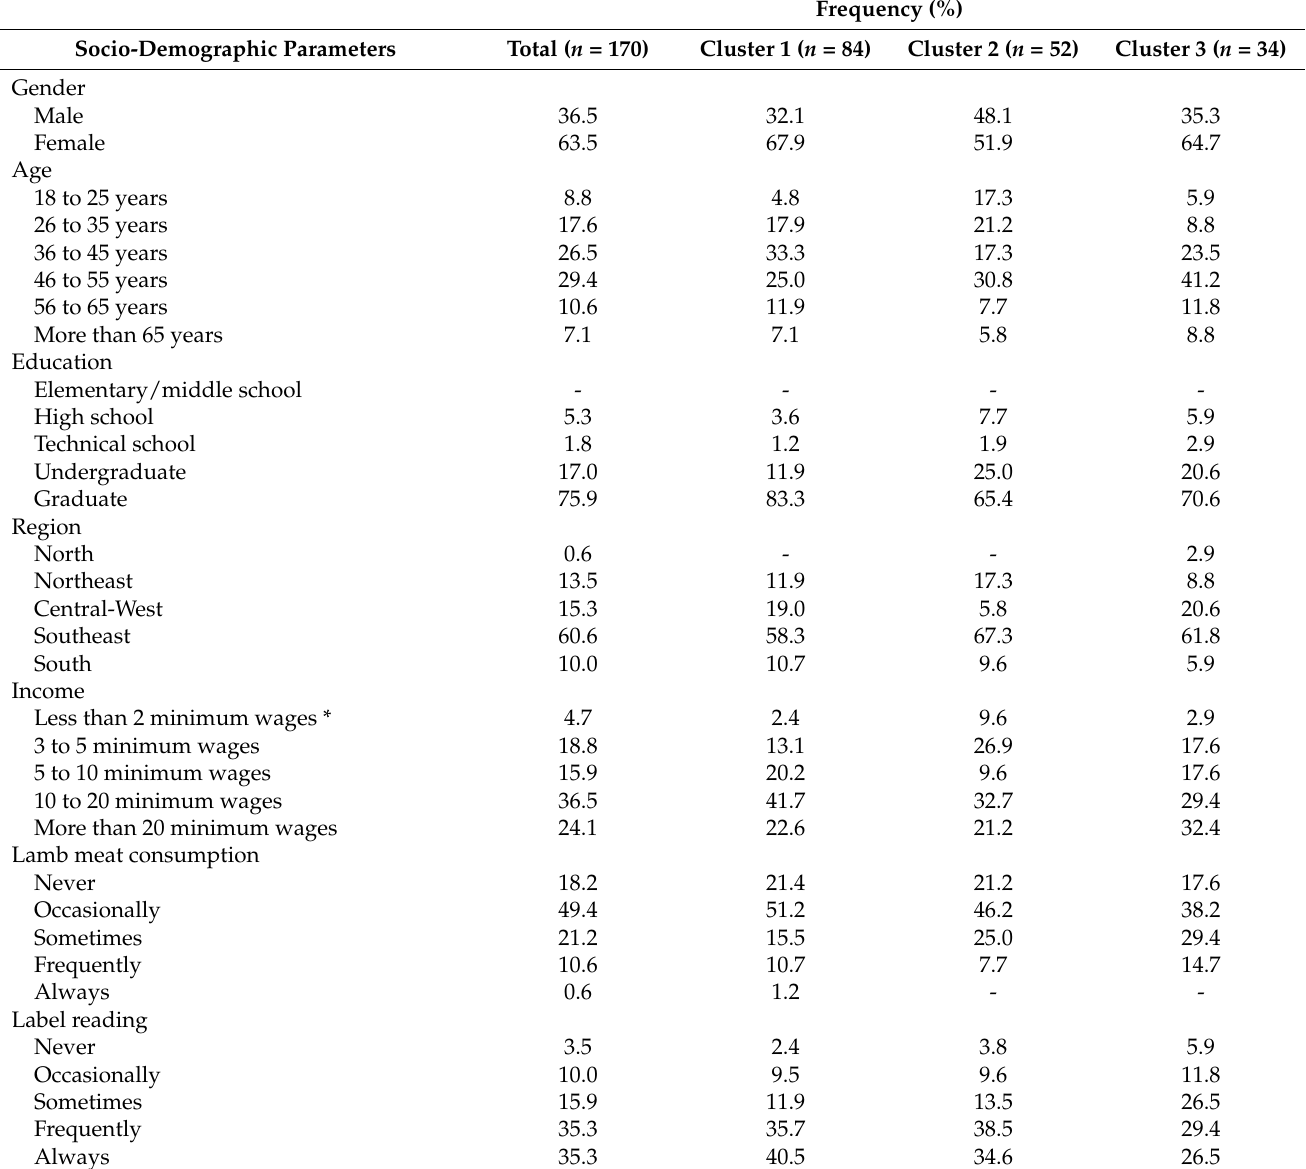
Table 1. Frequency of socio-demographic characteristics of